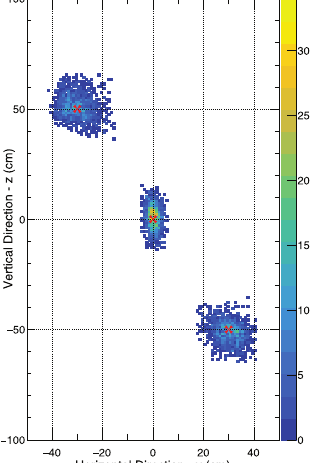
Fig. 1. CNGET imaging of a 1.7 µ Ci Cf-252 source. The plot shows the source positions calculated by the ANN for a total number of 1440 1-min measurements in each of three different positions (indicated by the red crosses) in the central plane of the detector system. The colour scale on the right indicates the number of measurement results per 1 cm 2 pixel. Taken from reference [6].